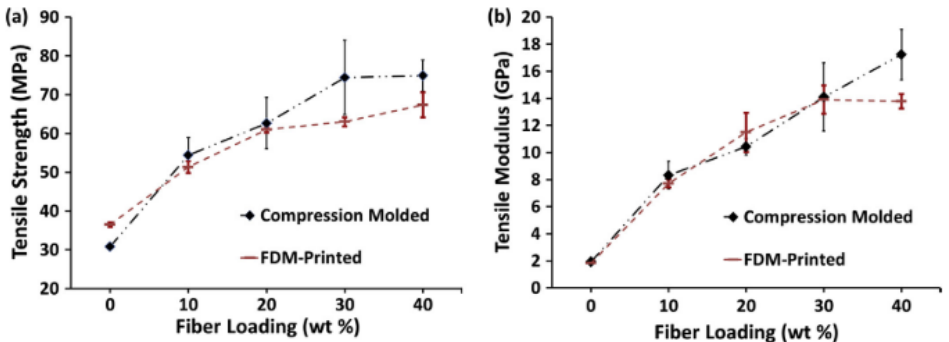
Figure 14. Typical tensile stress-strain curves for specimens with different carbon fiber contents ( a ) tensile strength, and ( b ) modulus, of ABS/CF composites. Reprinted with permission from [76], 2014, Elsevier, Amsterdam, The Netherlands.